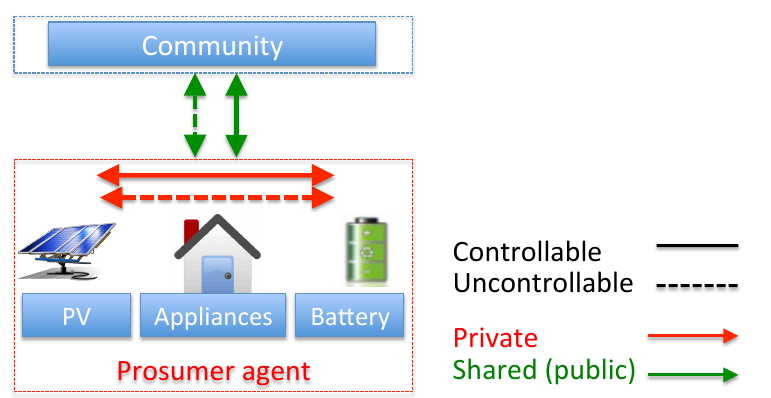
Figure 6. A prosumer agent has uncontrolled and controlled power resources (storage, generation, appliances, etc.), and part of the resources can be shared with the